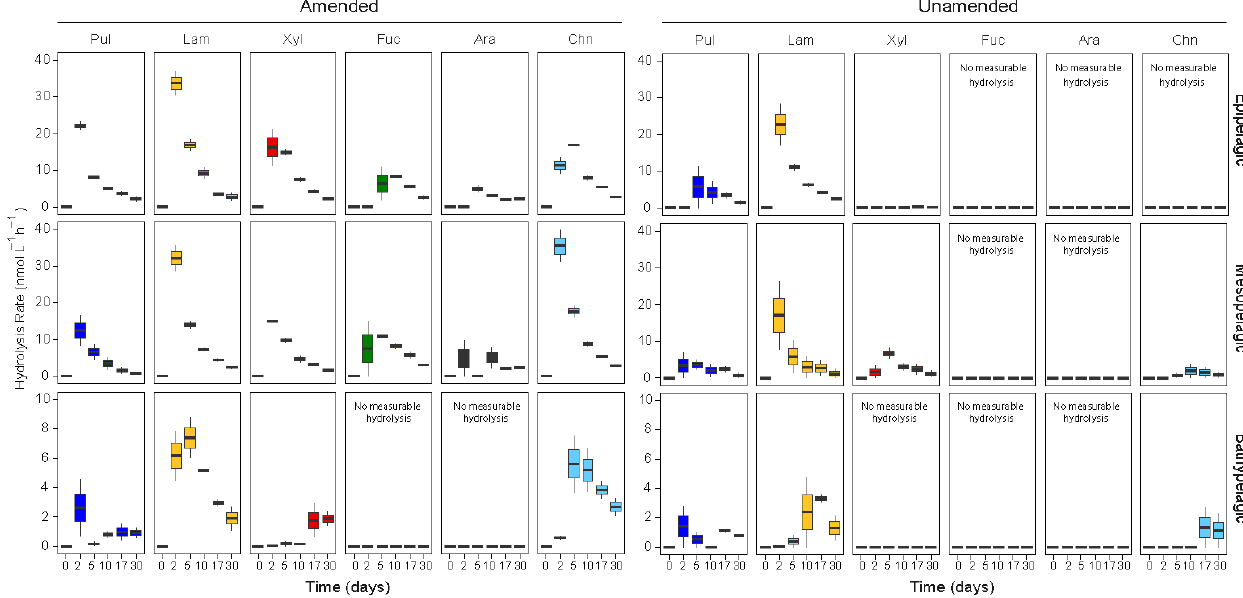
Figure 2. Polysaccharide hydrolase activities in amended and unamended mesocosms, averaged between stations. The spectrum of substrates (the range of substrates hydrolyzed) was considerably broader in amended compared to unamended mesocosms. Note that the 0d time point, when fluorescently labeled polysaccharide incubations began, was 15d after the addition of HMW organic matter to amended mesocosms. Note the large difference in scales between epi- and mesopelagic mesocosms (up to 40nmolL − 1 h − 1 ) and bathypelagic mesocosms (up to 10nmolL − 1 h − 1 ). Pul: pullulan, Lam: laminarin, Xyl: xylan, Fuc: fucoidan, Ara: arabinogalactan, Chn: